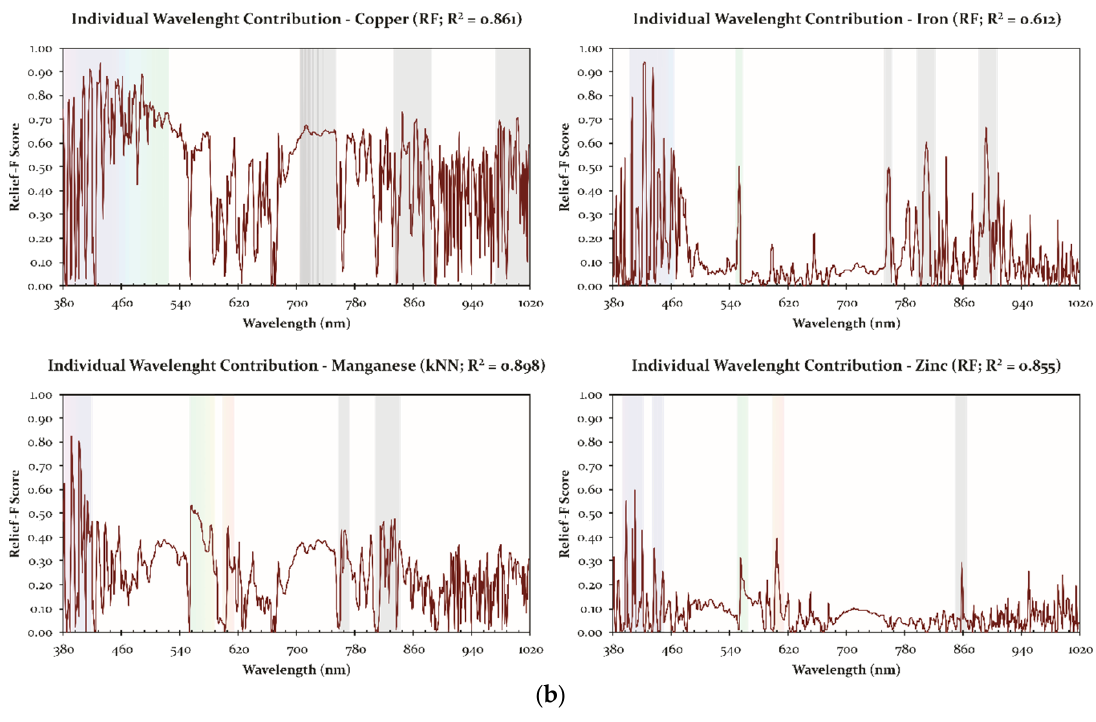
Figure 6. ( a ) The individual contribution of wavelengths for each macronutrients’ prediction. ( b ) The individual contribution of wavelengths for each micronutrients’ prediction. Table 6. Summarized information on the results obtained by the proposed